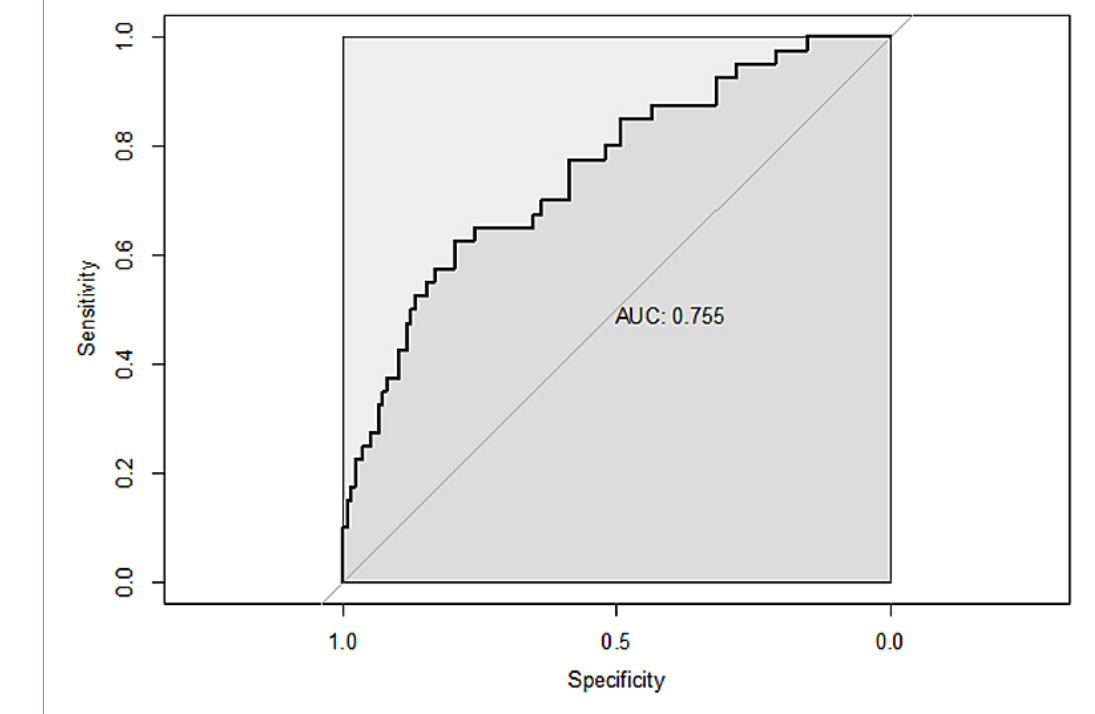
Figure S1: Receiver operator characteristics (ROC) curve for the prediction model for acute kidney injury in patients with